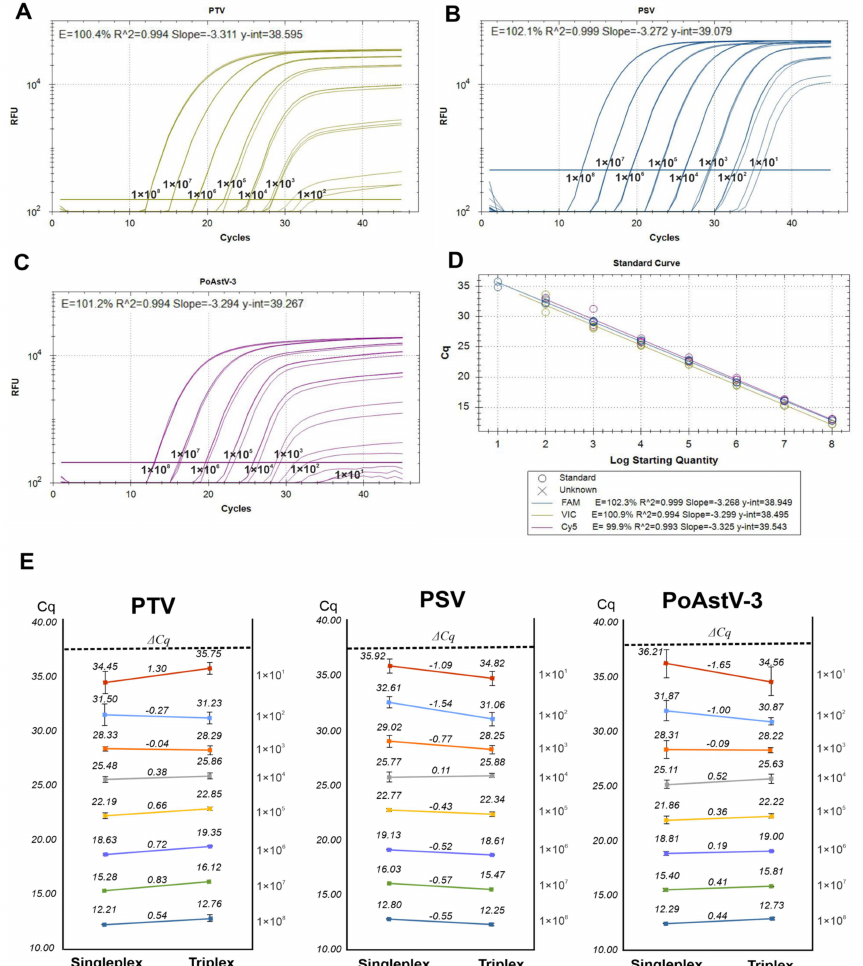
Figure 4. Amplification plots and standard curves of singleplex PTV ( A ), PSV ( B ) and PoAstV-3 ( C ) and triplex ( D ) assays using 10-fold serial dilutions of mixed PSV, PTV and PoAstV-3 RNA